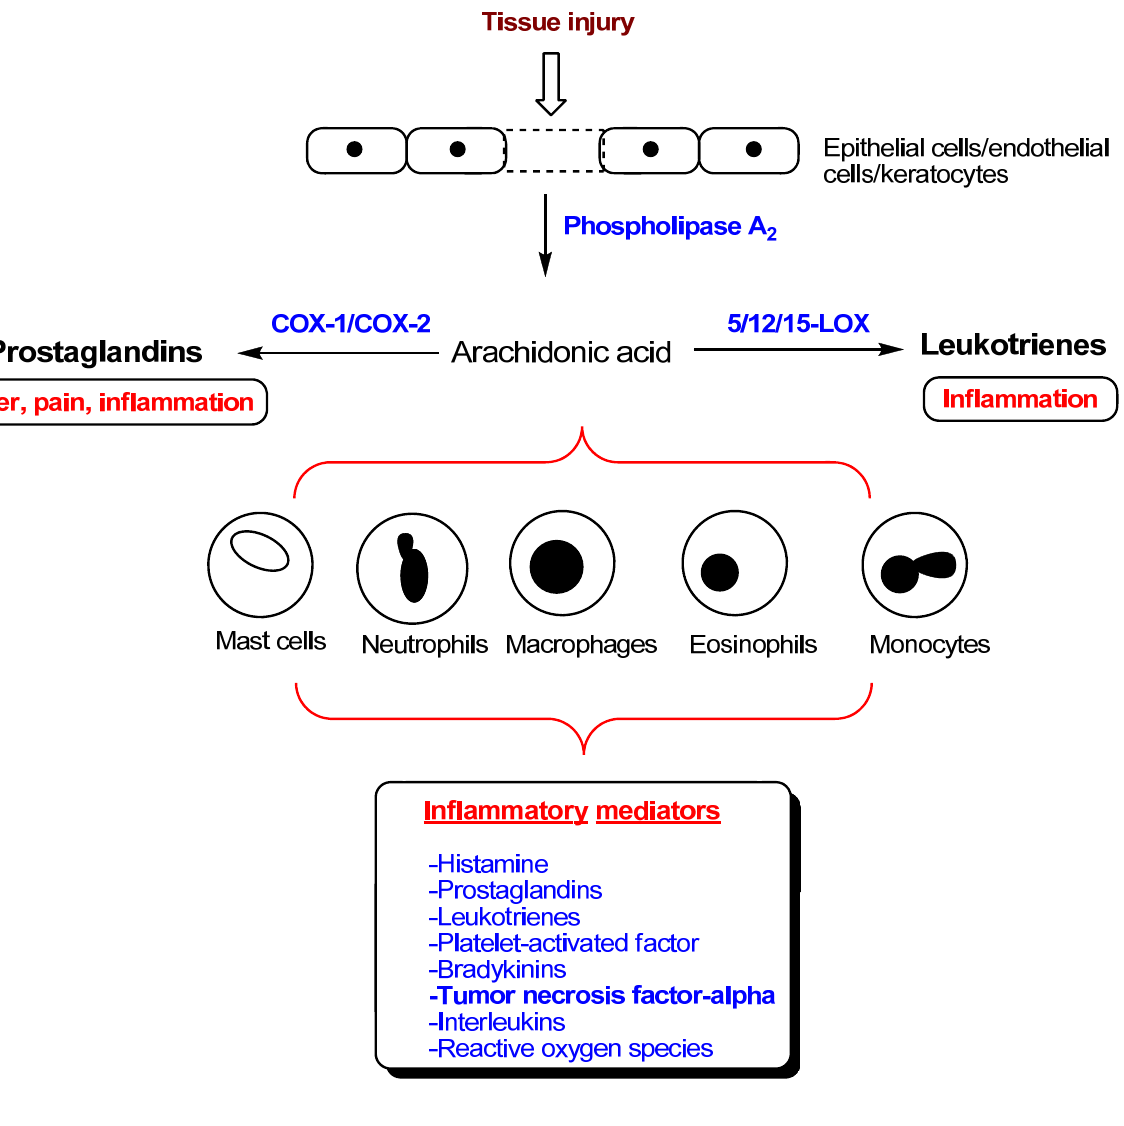
Figure 2. A simplified diagram of the inflammatory pathway and its